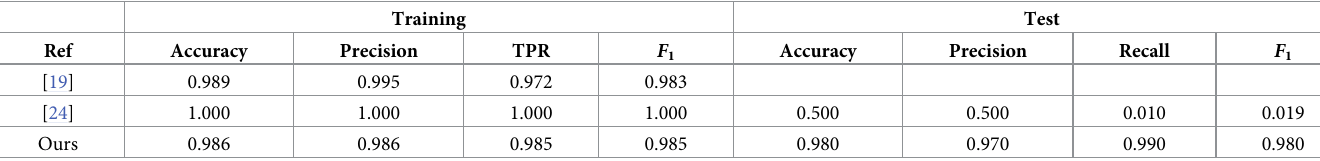
Table 7. Comparison of the proposed approach with related